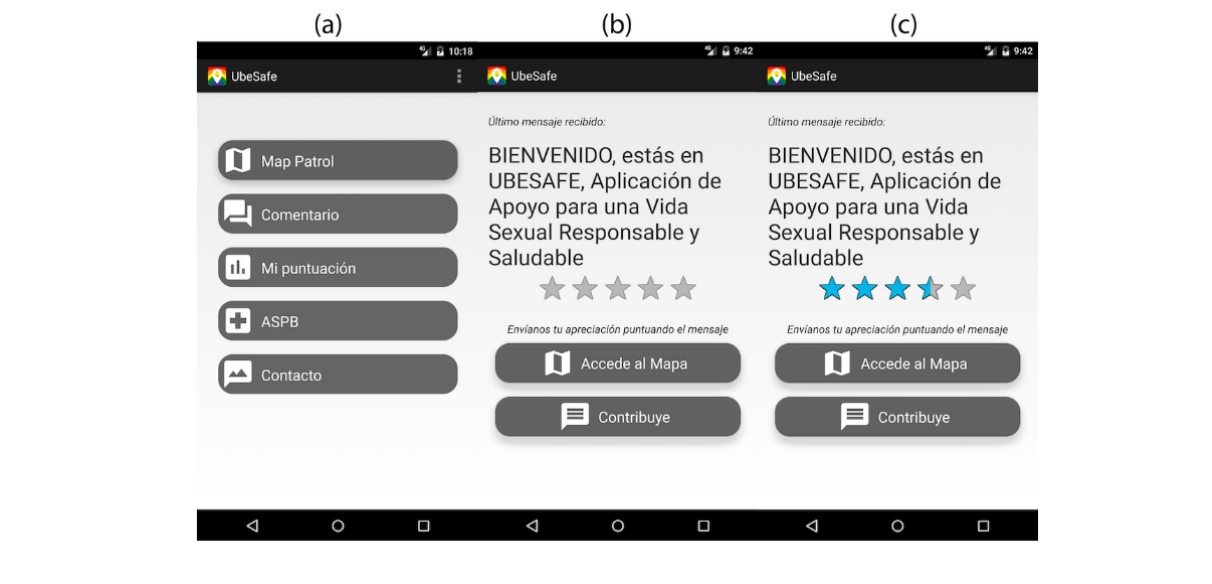
Figure 5. UBESAFE—Android client: primary interface for scoring messages with shortcuts for contribution and